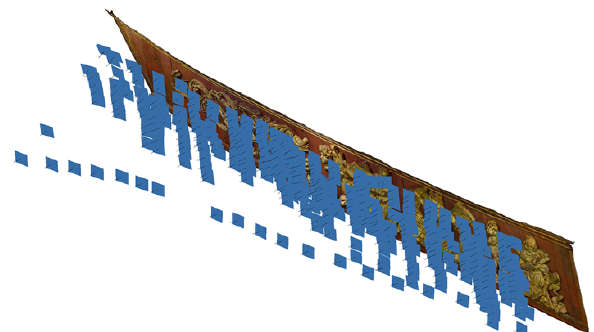
Figure 5. The photogrammetric model of the